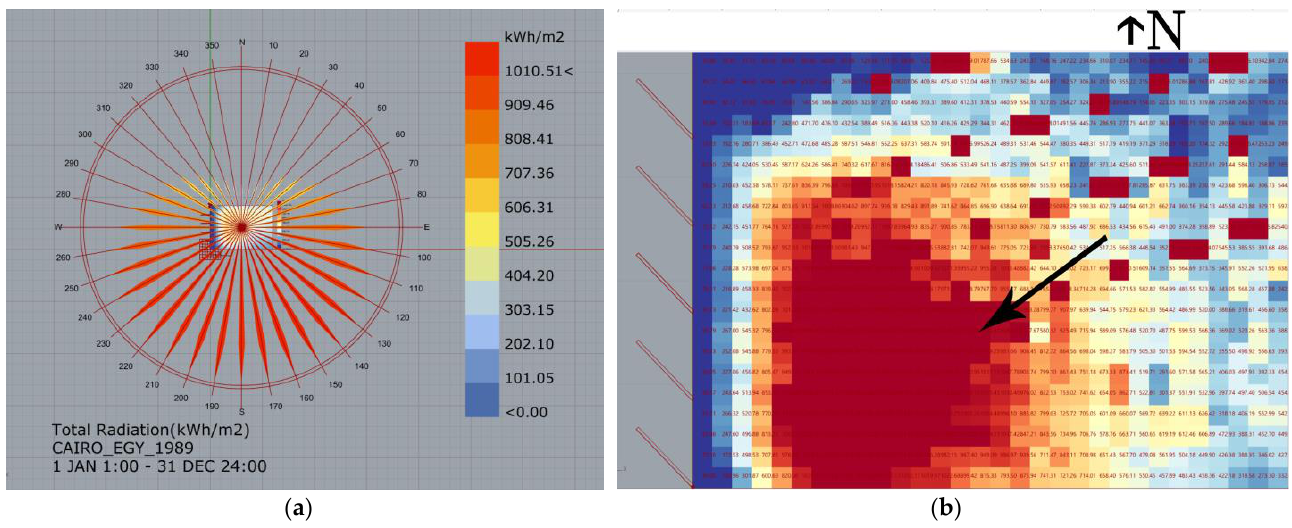
Figure 1. The unequal radiation on the western façade compared to the southern façade ( a ), the spot of the high illuminance values on the southwest location, ( b ).